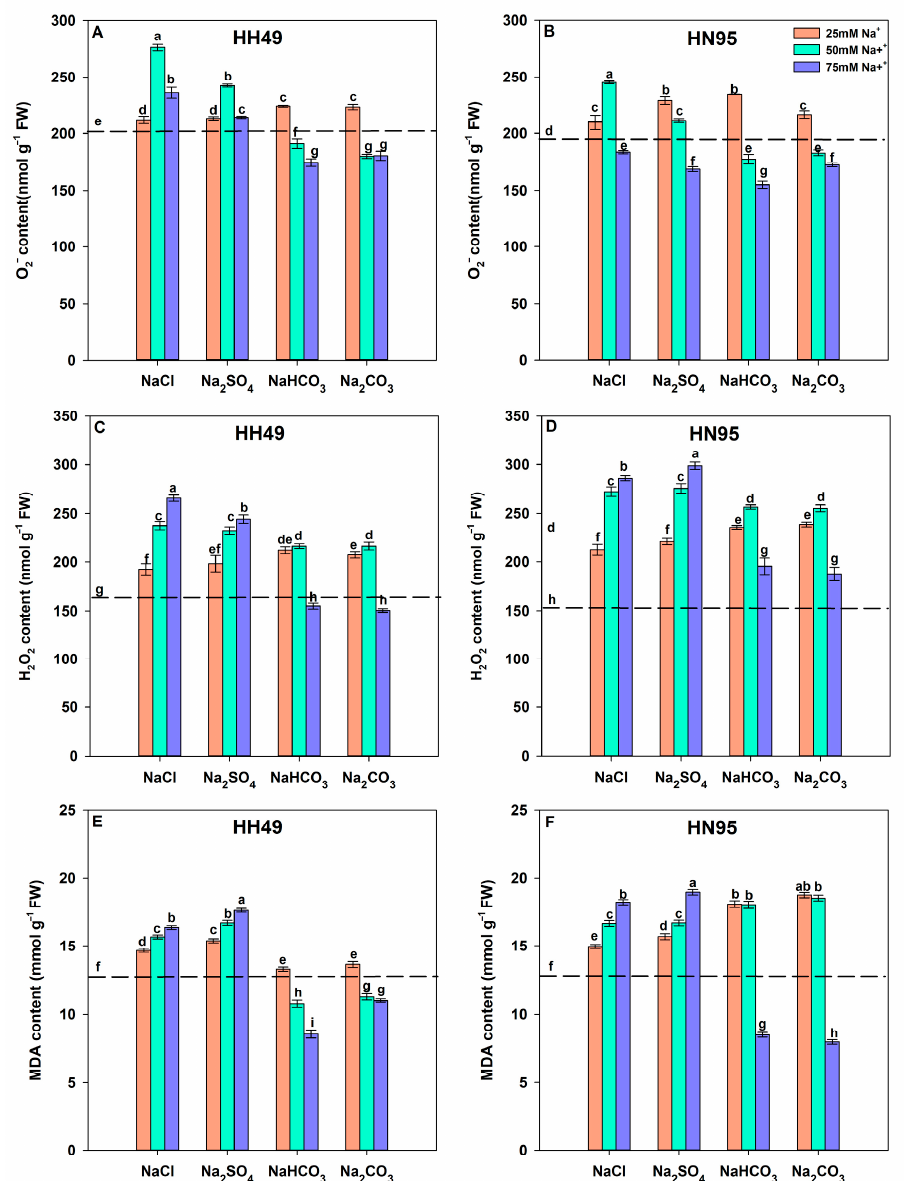
Figure 3. The ROS and MDA accumulation of soybean seedling roots treated with different types of salt stress for 3 days. The content of O 2 − ( A ), H 2 O 2 ( C ), and MDA ( E ) in HH49 seedling roots treated with different Na + concentration solutions in formulas of NaCl, Na 2 SO 4 , NaHCO 3 , and Na 2 CO 3 . The content of O 2 − ( B ), H 2 O 2 ( D ), and MDA ( F ) in HN95 seedling roots treated with different Na + concentration solutions in formulas of NaCl, Na 2 SO 4 , NaHCO 3 , and Na 2 CO 3 . Dashed lines in ( A – F ) indicate O 2 − , H 2 O 2 , and MDA content of HH49 and HN95 seedling roots under the control conditions. Data are expressed as means ± SD of three independent experiments. Different letters indicate statistically significant differences ( p < 0.05) among